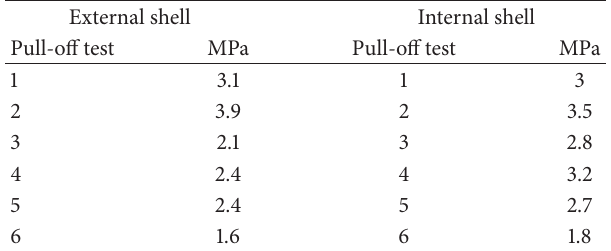
Table1:Measurementsofpull-offtestforexternalandinternalshell.